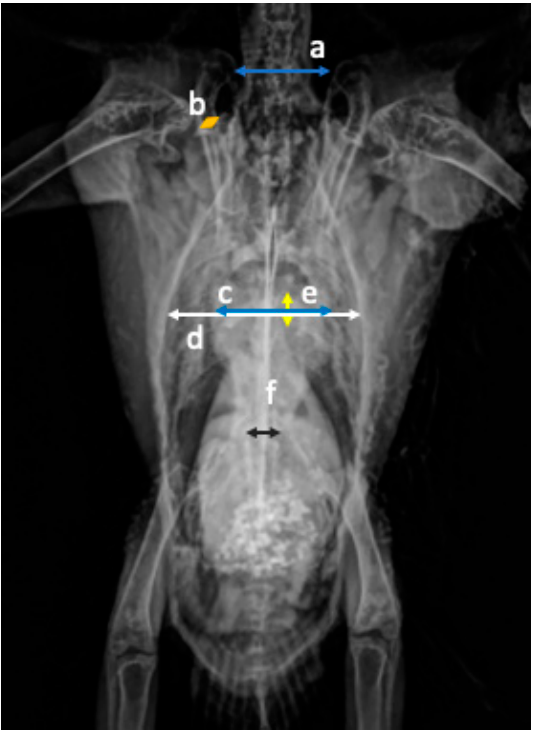
Figure 1. Ventrodorsal (VD) projection and measurements in a radiograph of a wild galah: ( a ) distance of the clavicle cranial to the shoulder joint (blue); ( b ) coracoid width immediately caudal to the shoulder joint (orange); ( c ) width of the heart at the widest point (light blue); ( d ) width of the thorax at the same height as the heart width (white); ( e ) distance between the third and fourth ribs parallel to the spine (yellow); ( f ) synsacrum at the widest point (black).